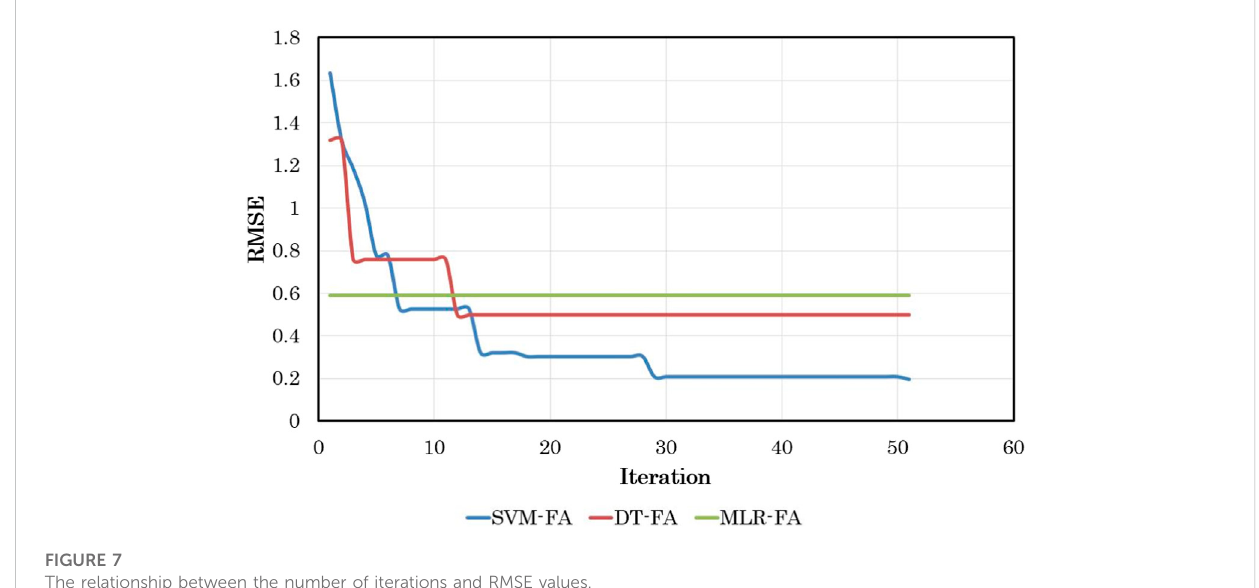
FIGURE 7 The relationship between the number of iterations and RMSE values.